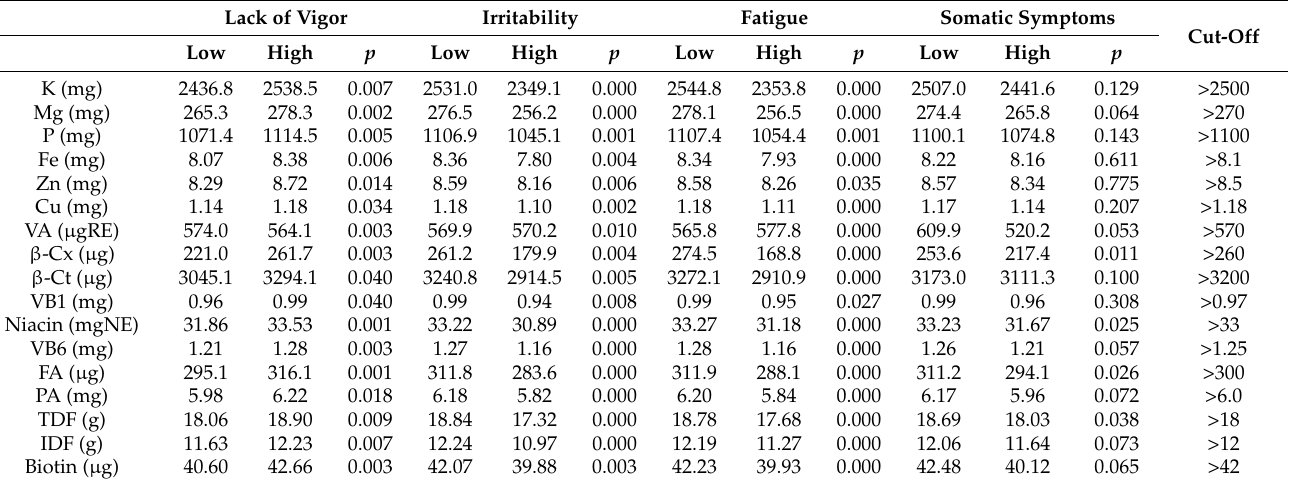
Table 3. Intakes of seventeen nutrients in each